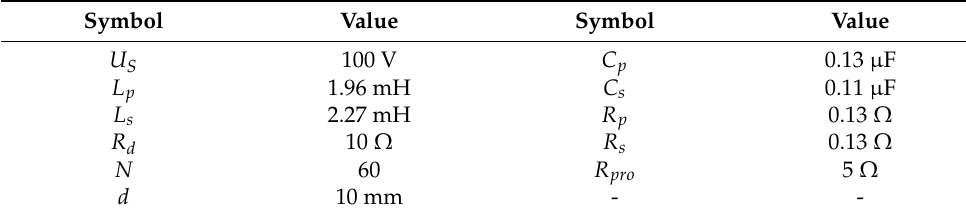
Table 2. SISO system prototype parameters.